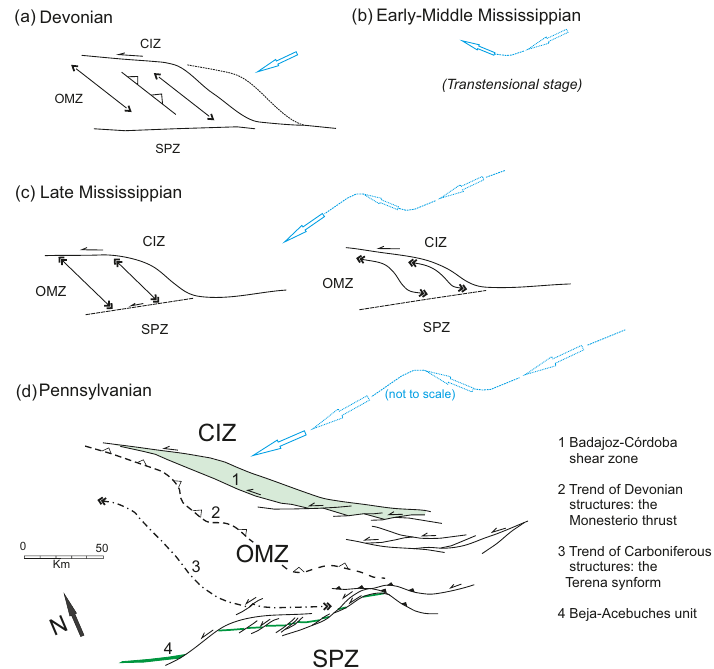
Figure 4. (a–d) Schematic evolutionary model of the deformations inside de OMZ from the Devonian to the Pennsylvanian period. See text for further